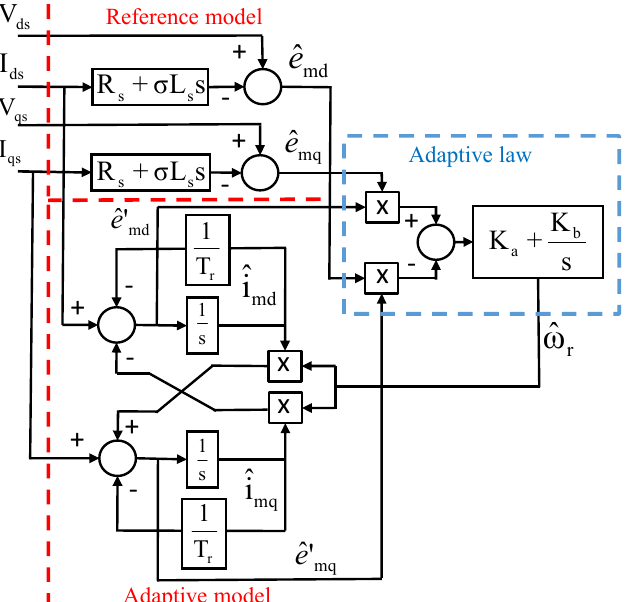
Figure 3. Block diagram of the MRAS Back-EMF rotor speed observer (from